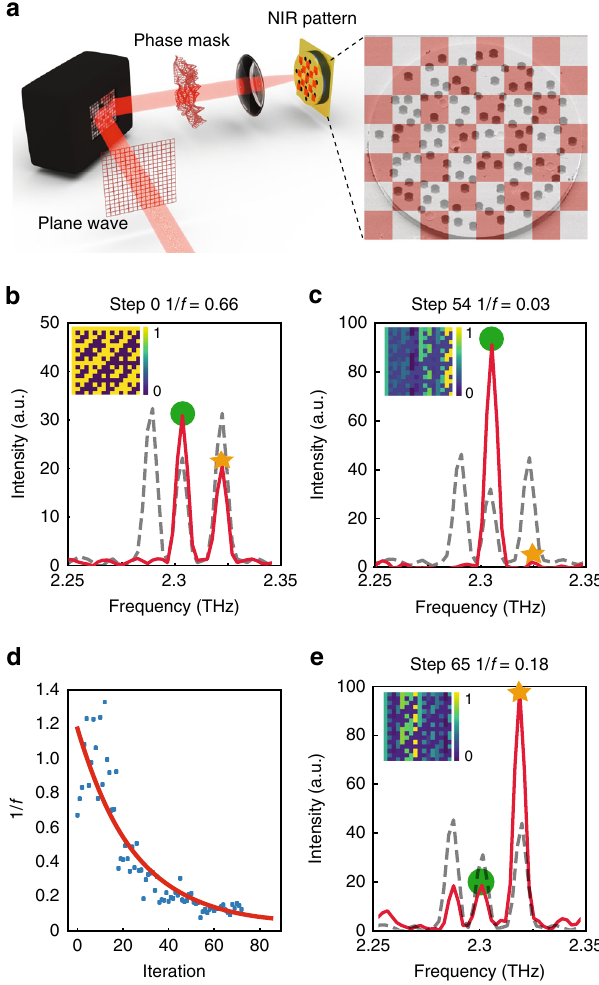
Fig. 2 Mode selection in QCRLs through patterned NIR illumination. a Setup performing a patterned NIR illumination on the QCRL. The fi eld emitted from the Ti:Sapphire ( “ Plane wave ” ) is phase-modulated by a spatial light modulator used in re fl ection mode (black box). The resulting fi eld ( “ Phase mask ” ) is Fourier-transformed by a lens to produce an intensity pattern on the device ( “ NIR pattern ” ) ( “ Methods ” ). For illustration purposes, an example of a chess-board-like patterned illumination is provided in inset (right-hand side). b Starting point for the iteration of the optimization routine applied to a mode at 2.3THz (Step 0). An initial non-uniform pattern is projected onto the QCRL (blue-yellow array in inset). The solid red curve corresponds to the spectrum collected under this non-uniform NIR illumination. The dashed gray curve shown here and in panels c and e was recorded without NIR perturbation. The green dot indicates the mode at 2.3THz that the procedure intends to optimize, while the orange star indicates a second mode (at 2.32THz) whose intensity should be reduced. c Final iteration of the optimization applied to the mode at 2.3THz (Step 54). The algorithm converges towards a complex spatial modulation of the perturbation (blue-yellow array in inset) producing a single-mode emission at 2.3THz (green dots). d Evolution of the function 1/ f for the optimization displayed in b and c . e Final iteration of the optimization applied to a mode at 2.32THz (step 65). The mode marked by an orange star (2.32THz) is optimized by a non-uniform pattern (blue-yellow array in inset) obtained after 65